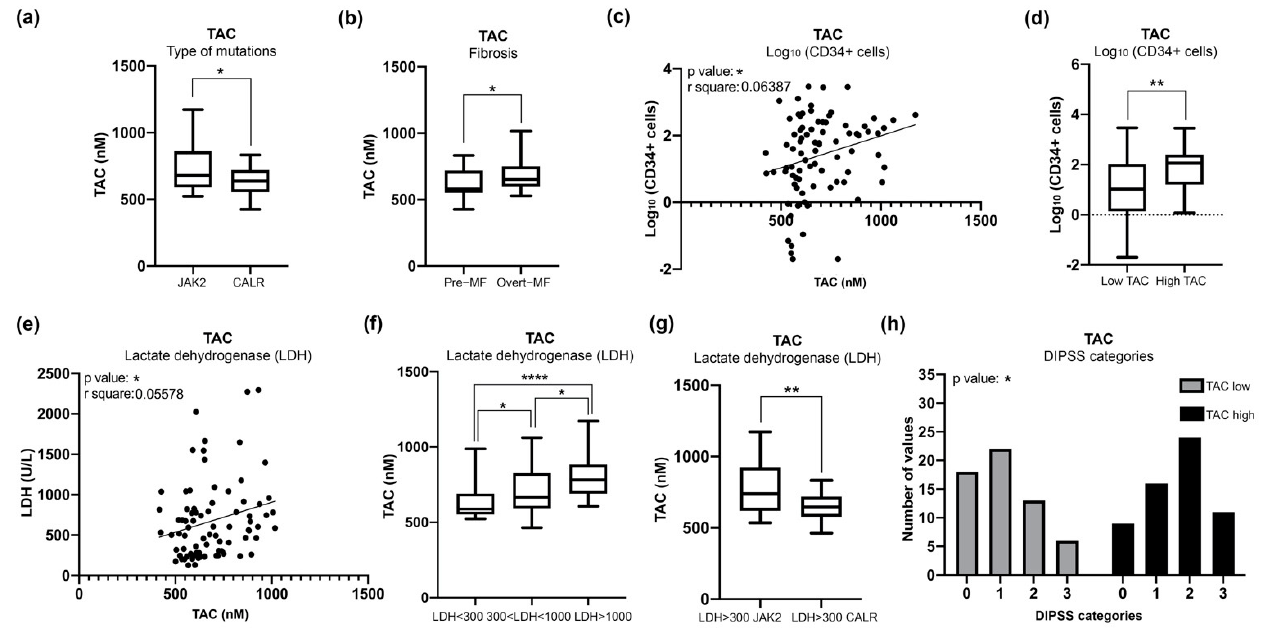
Figure 4. Measurement of TAC in plasma of MF patients and correlation with clinical detrimental features. ( a ) Box plot shows the level of TAC in CALR and JAK2 -mutated MF patients. ( b ) Box plot shows correlation analysis of TAC level with fibrosis. ( c ) Graph represents linear regression analysis in MF patients showing correlation between the count of circulating CD34+ cells and TAC levels. ( d ) Box plot represents correlation analysis of the count of circulating CD34+ cells in MF samples presenting low or high levels of TAC. ( e ) Graph represents linear regression analysis in MF patients showing correlation between serum LDH and TAC levels. ( f ) Box plot represents correlation analysis of TAC levels with levels of serum LDH in MF samples divided into three ranges: LDH < 300, 300 < LDH < 1000, LDH > 1000 nM. ( g ) Graph showing correlations between JAK2- and CALR -mutated patients with LDH > 300 nM and TAC plasma levels. ( h ) Histogram was obtained from contingency tables computed to correlate low or high TAC plasma levels and DIPSS classification; the analysis was conducted with Chi-square test. Samples with low or high TAC levels are represented in gray and black, respectively. Box plot data are reported as median with 95% CI; the comparisons between two categories were analyzed with Mann–Whitney U test, while multiple comparisons were analyzed with Kruskal Wallis test. * p < 0.05, ** p < 0.01, **** p <